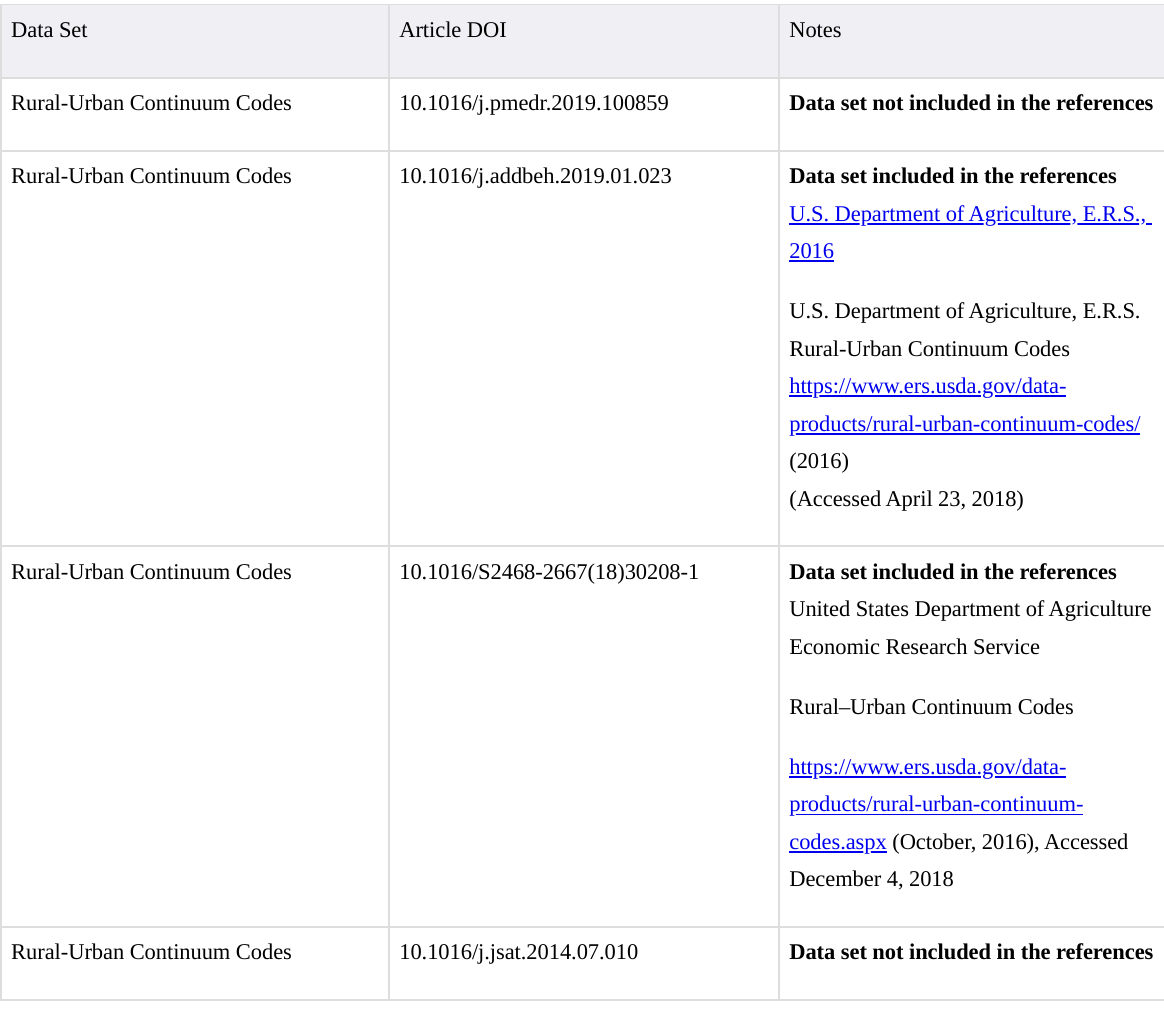
Table A2. Examples of false